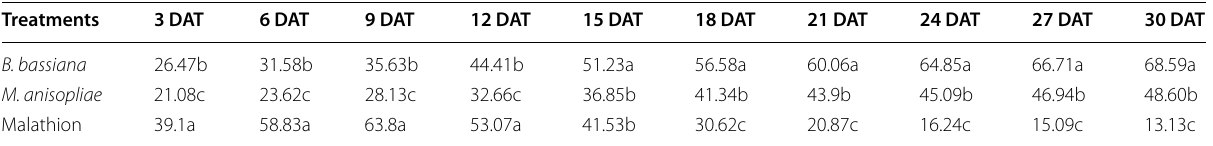
Table 2 Impact of entomopathogenic fungi ( Beauveria bassiana and Metarhizium anisopliae ) on corrected population reduction (%) of Bactrocera cucurbitae under field conditions (pooled data 2017 and 2018)